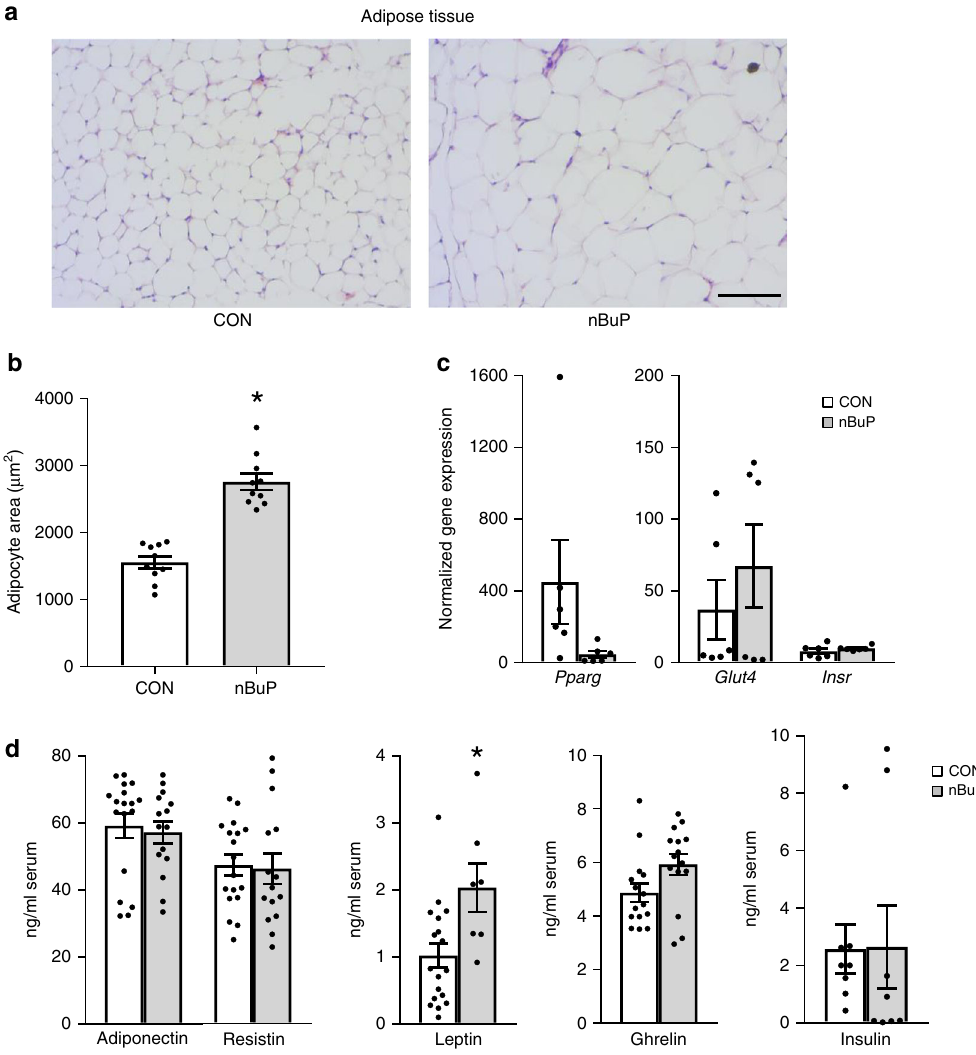
Fig. 3 Perinatal nBuP exposure, adipocyte area and gene and protein expression of key genes in the offspring. a Representative picture of stained slices (H&E, ×20, scale bar: 100 µ m) of visceral adipose tissue and ( b ) the illustration of the adipocyte area from female offspring of nBuP-exposed dams ( n = 10), ( c ) The mRNA expression levels of selected target genes investigated in adipose tissue of female offspring ( n = 6), ( d ) Levels of adiponectin and resistin (CON: n = 18, nBuP: n = 15), leptin (CON: n = 18, nBuP: n = 7), ghrelin ( n = 15) and insulin ( n = 8) measured in serum of female offspring. Data are expressed as mean ± SEM, * P < 0.05, unpaired t -test. Source data are provided as a Source Data fi